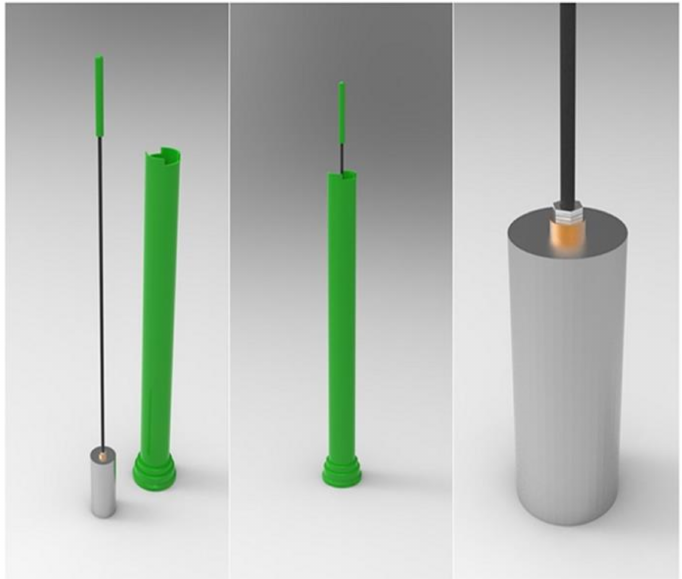
Figure 5. Custom impact test device (ITD) built to perform similarly to the device described in ASTM